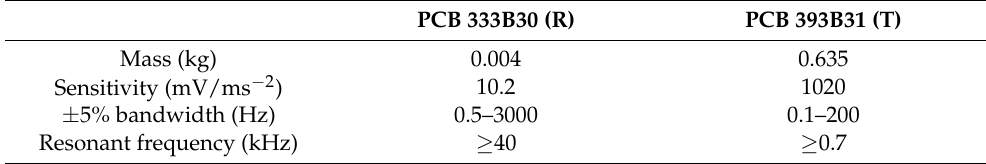
Figure 8. Shaker driving signal for random excitation.